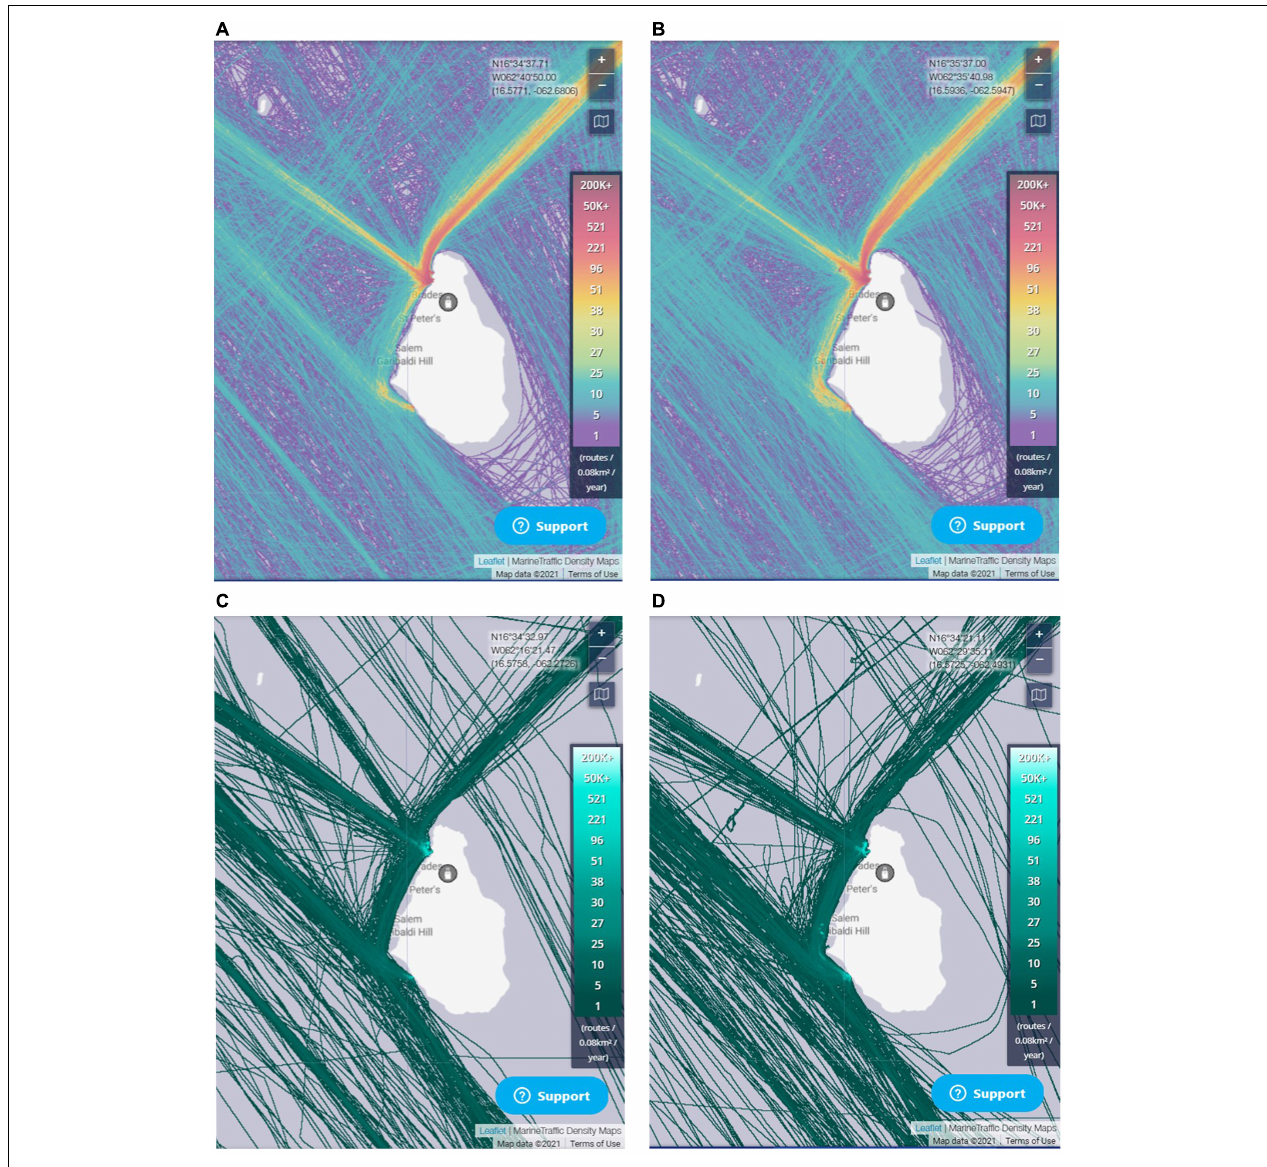
FIGURE 4 | Vessel density data from MarineTraffic.com. (A) Density of all vessels in 2018. (B) Density of all vessels 2019. (C) Density of tugs and special craft in 2018. (D) Density of tugs and special craft in